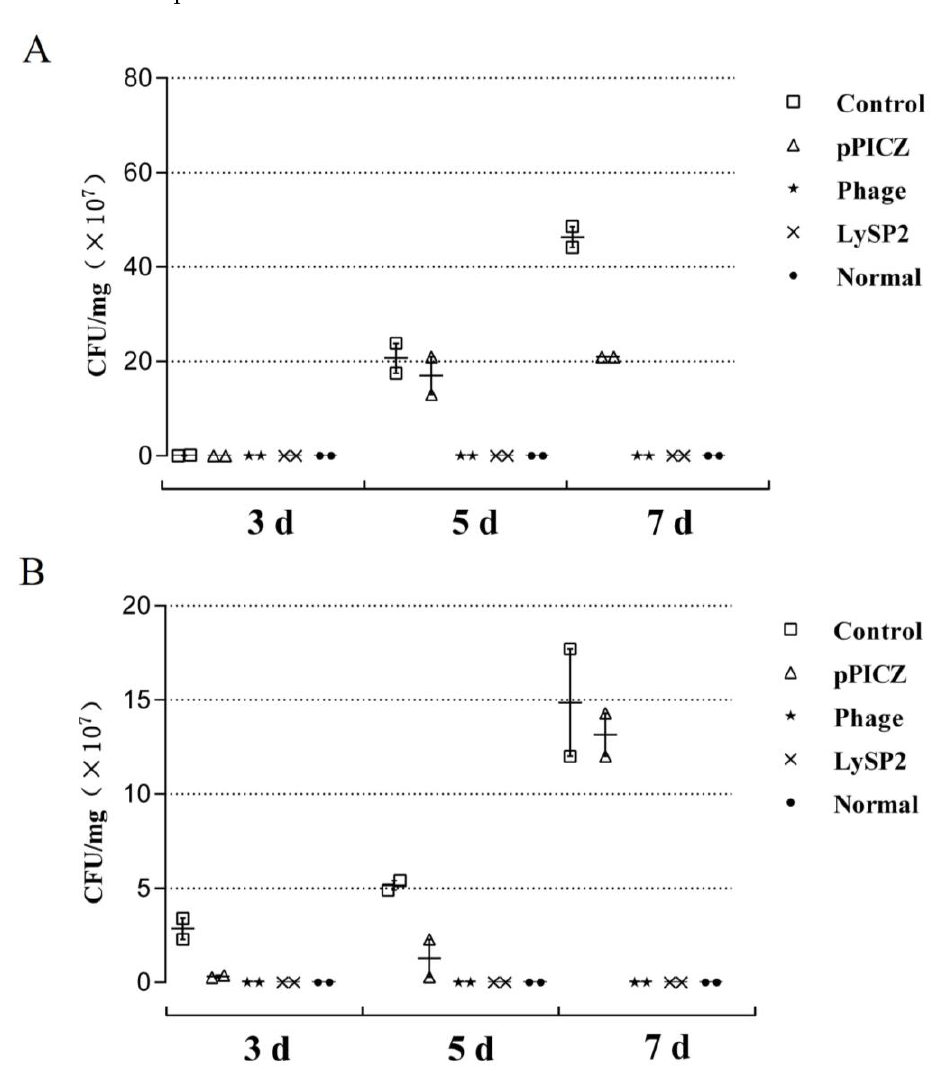
Figure 5. Bacterial counts. Liver ( A ) and intestinal ( B ) Salmonella count. Values are the mean ± SD of three determinations.